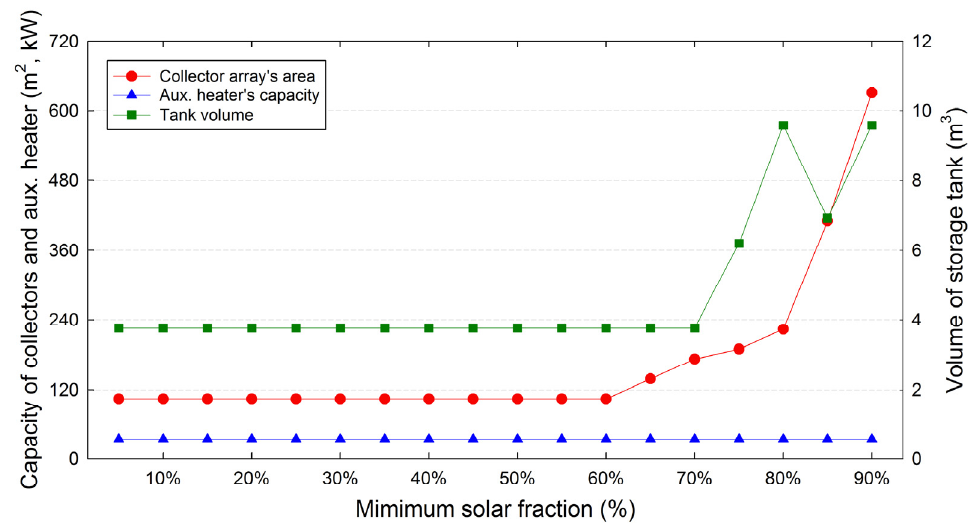
Figure 9. Variation of component sizes at the different minimum solar